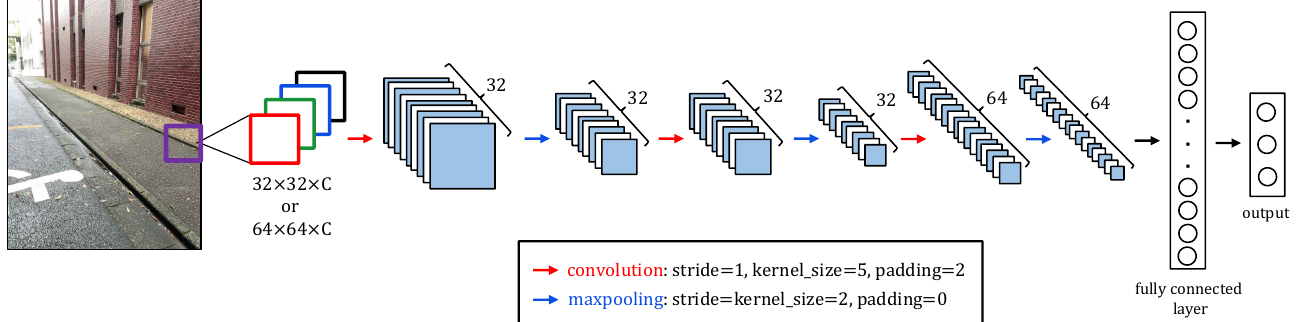
Figure 8. Convolutional neural network architecture for difference-in-level